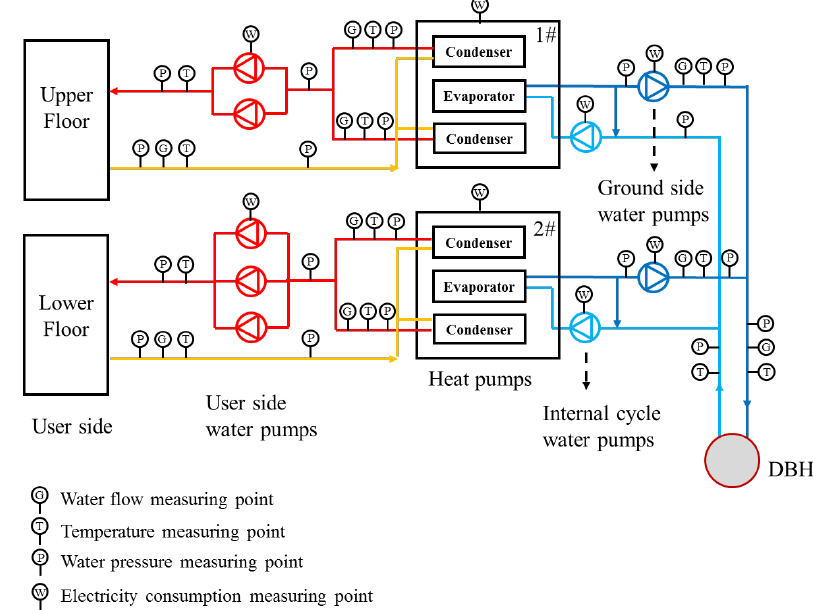
Figure 1. System diagram and measuring points of medium-depth geothermal heat pumps system (MD-GHPs).